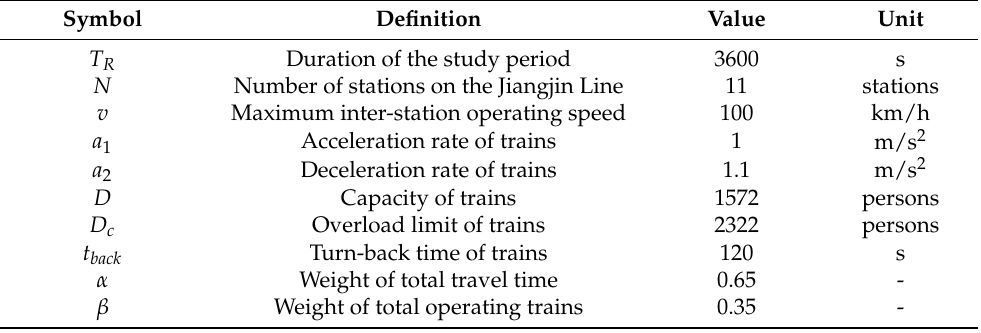
Table 3. Parameter values.